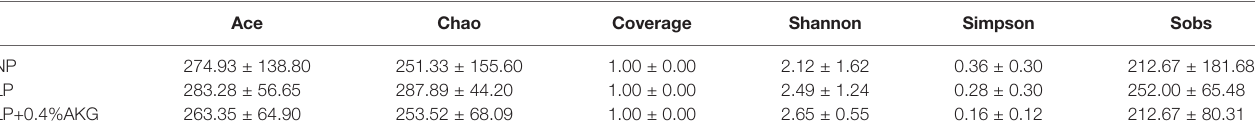
Three intestine from each of the three tanks were tested. Values are expressed as the means ± SEM (n = 3), and different superscript letters in the same row are signi fi cantly different (P <